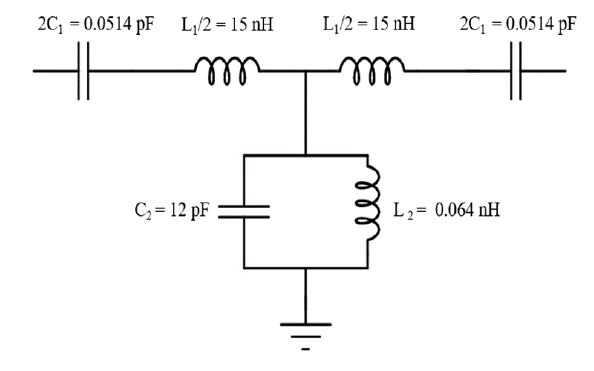
FIGURE. 6. EQUIVALENT CIRCUIT OF SYMMETRICAL RING RESONATOR BANDPASS FILTER.